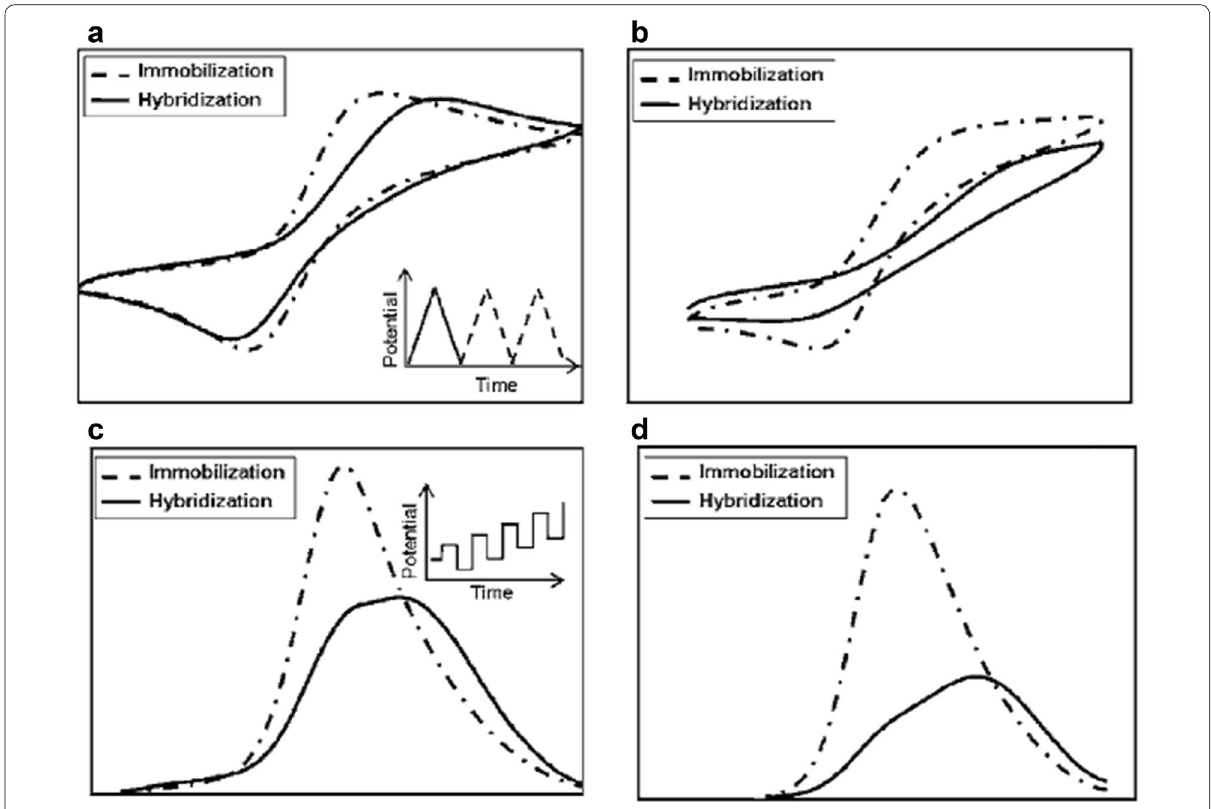
Fig. 13 Electrochemical assay of label-free DNA protocol on an electrode utilizing a 200 μm diameter electrode b NWA with 50 nm diameter (number of 200 200). Electrochemical measurement (square-wave voltammograms and cyclic voltamogram were carried out in 10 mM K3Fe(CN)6 × solutions at a scan rate of 100 mV/s: before immobilization (dotted line), and after hybridization (solid line) with a complementary target 21-mer oligonucleotide. Electrochemical response change between the redox current after immobilization ( Iim ) and after hybridization ( Ihy ) in the 200 μm electrode a , b and NWA electrodes c , d . The concentration of probe DNA and complementary target DNA was 50 μM/100